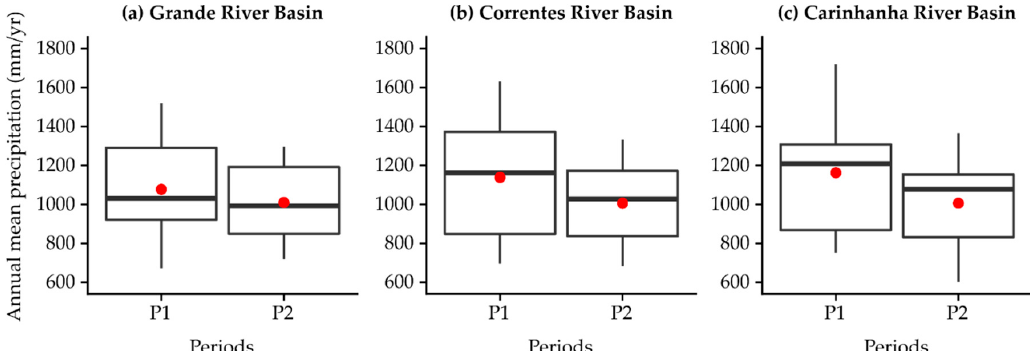
Figure 6. Boxplot displaying the median (thick lines), the lower and upper quartile (box), the mean (red dots), and the minimum and maximum of the distribution (whiskers) for annual values of precipitation in periods P1 and P2. Period P1, although much shorter than P2, has higher interannual variability.